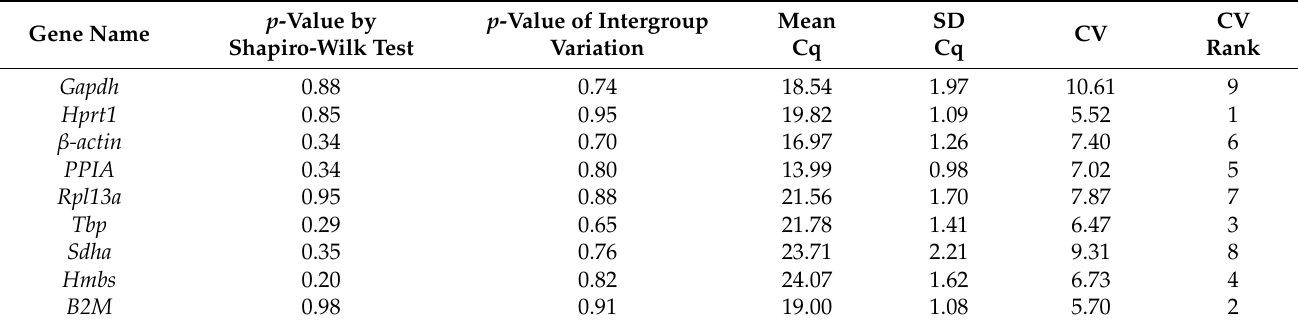
Table 11. Expression features in hypothalamus tissues at the developmental stage of PND 24w under different photoperiod conditions analyzed by SPSS.